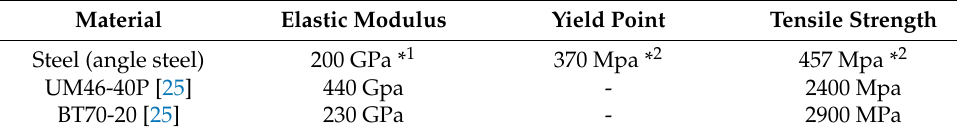
Table 3. shows the specifications for the steel and carbon fiber cloths. Table 3. Material